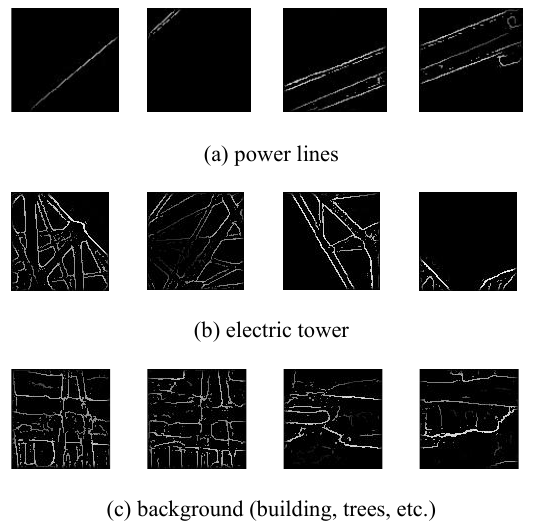
Figure 7. Predicted edge maps generated after NMS Three images with different angle of views are selected as input images, each of them includes complete structure of power lines and the background is relatively clear, and one of the results is shown in Figure 8.